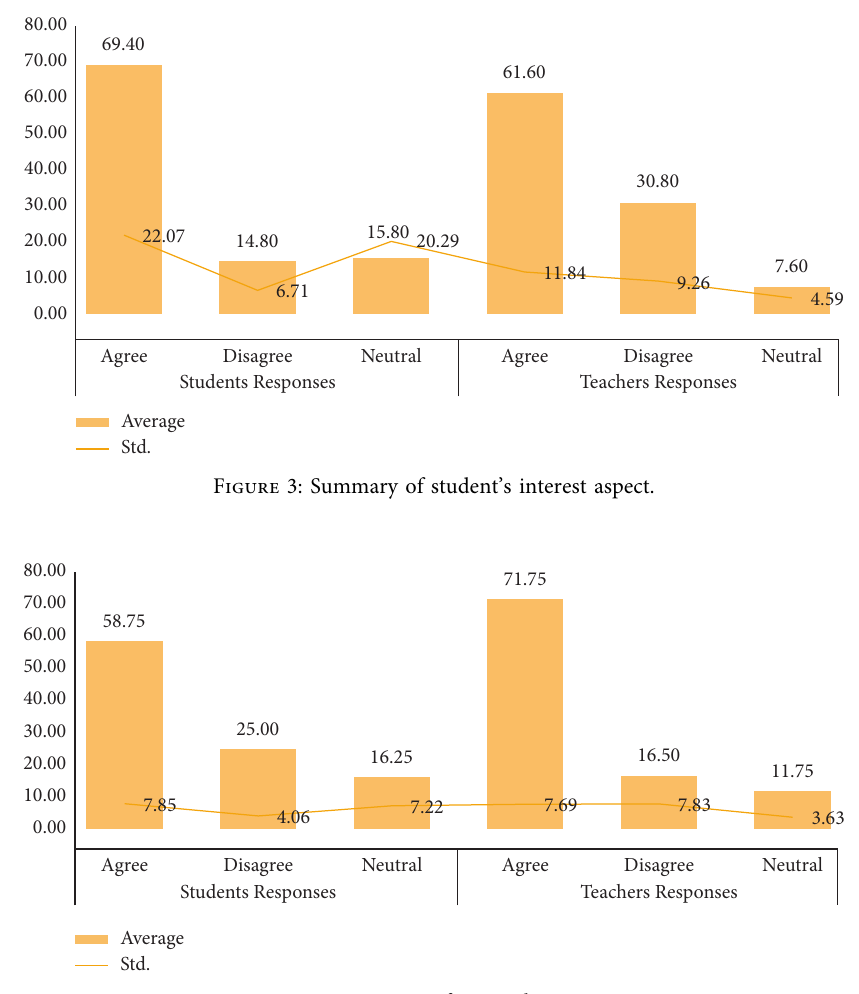
Figure 4: Summary of curriculum